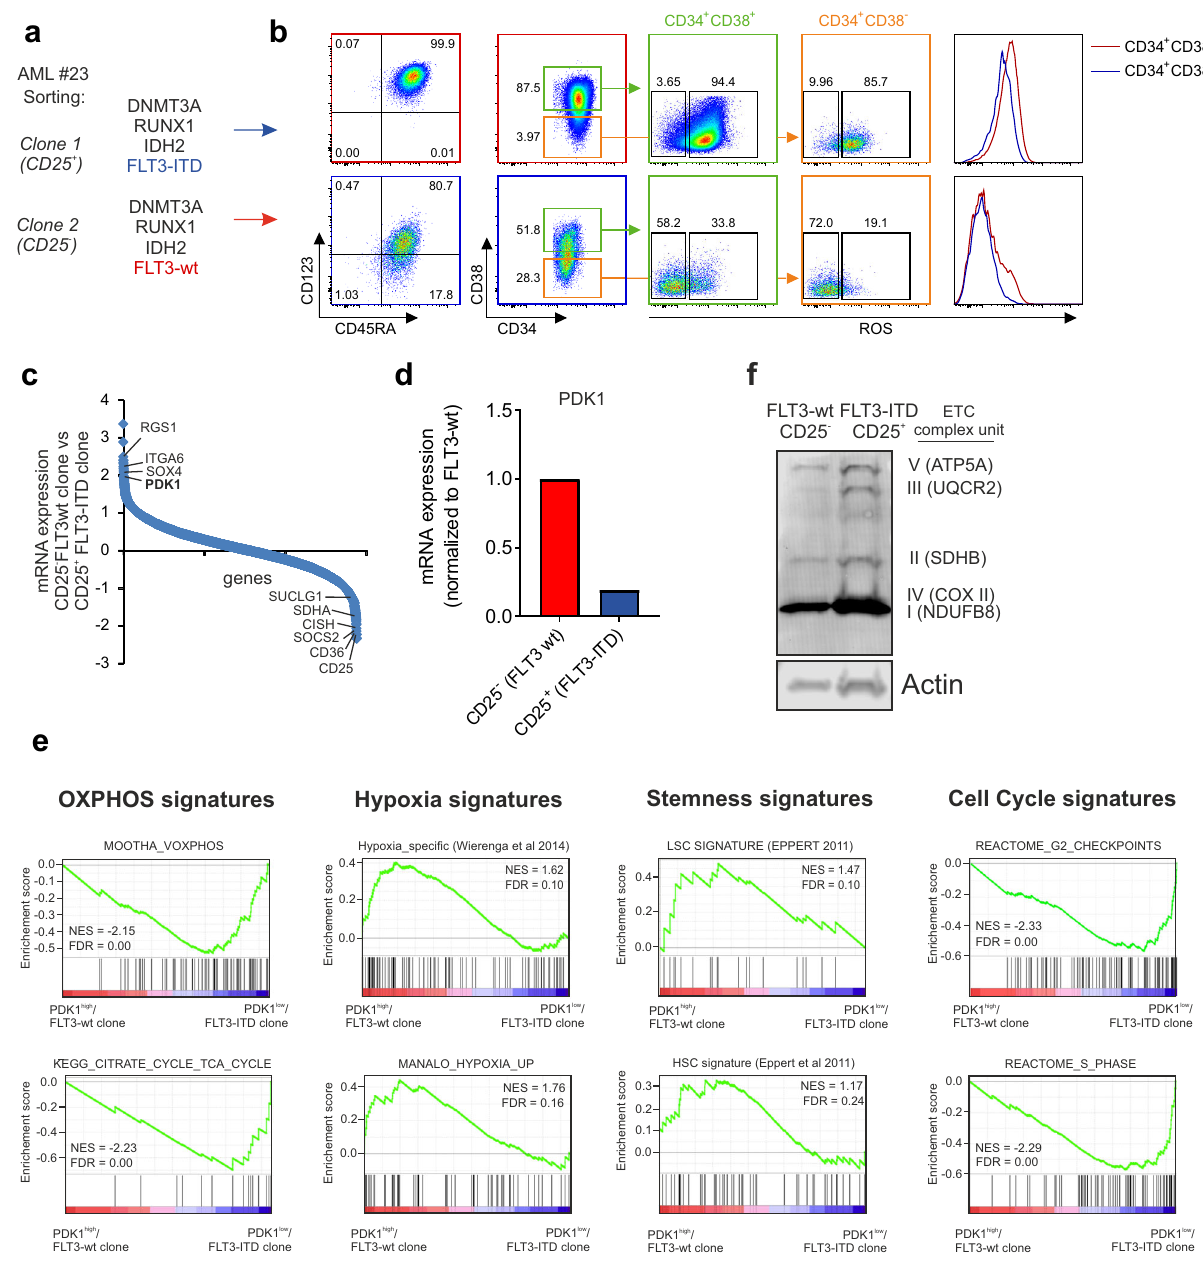
Fig. 3 Subclone-speci fi c metabolic differences in an individual patient. a Two genetically distinct subclones could be identi fi ed and prospectively sorted on the basis of differential CD25 expression (based on ref. 7 ). b ROS levels were low in the CD34 + /CD25 − FLT3-wt subclone 2 and high in the CD34 + / CD25 + FLT3-ITD subclone 1. c RNAseq of the CD34 + /CD25 − FLT3-wt subclone was compared to the CD34 + /CD25 + FLT3-ITD subclone. d , PDK1 mRNA levels were highest in the CD34 + /CD25 − FLT3-wt subclone. e Gene set enrichment studies performed on the ranked gene list depicted in c . f Western blot analysis of ETC Complex subunits; Complex I (NDUFB8, 18 kD), II (SDHB, 29 kD), III (UQCRC2, 48 kD), IV (COX II, 22 kD) and V (ATP5A, 54 kD) in FLT3- ITD mutant and FLT3-wt AML subclones (whole-cell lysates). Equal amount of protein loaded from both subclones and Actin used as the loading control.